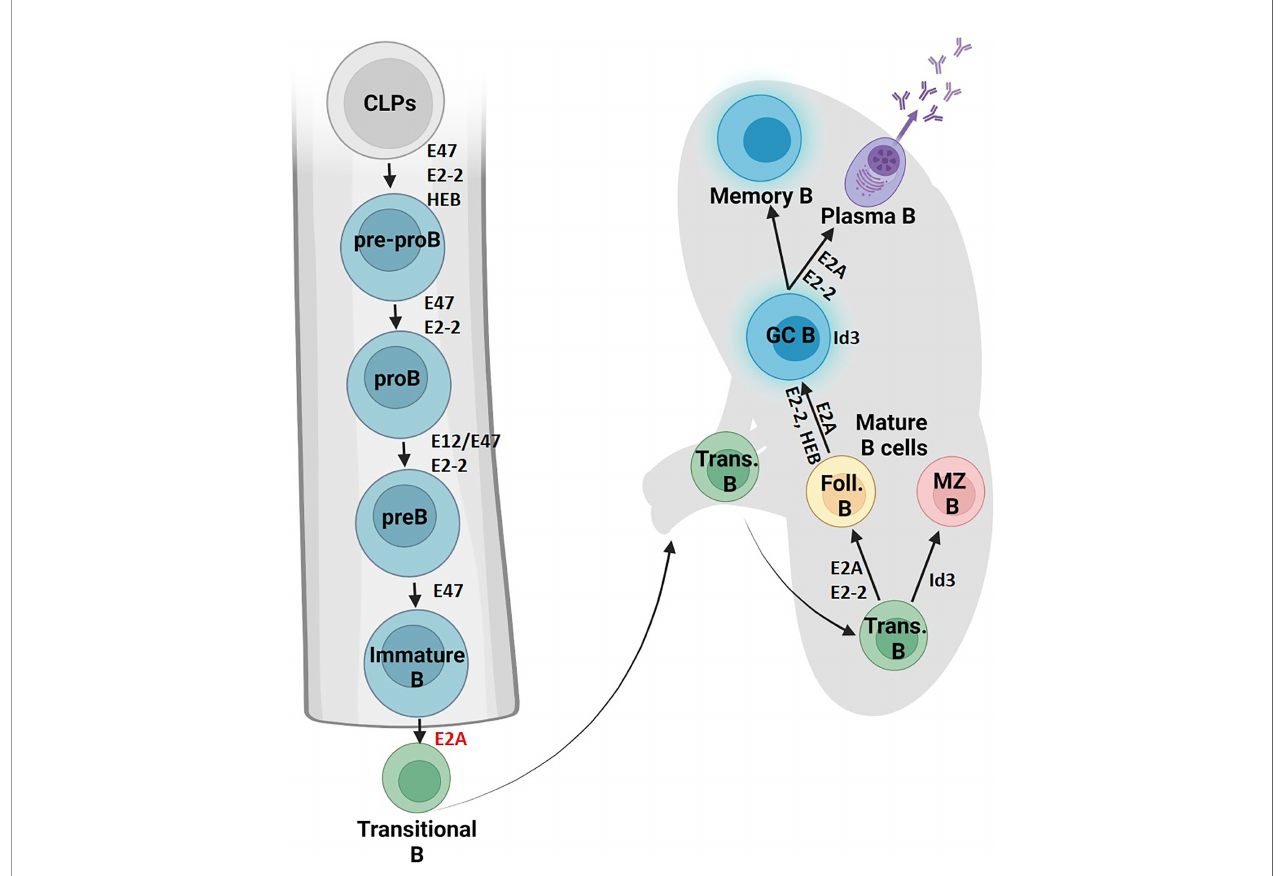
FIGURE 2 | B cell fate and differentiation is directed by E protein activity. The role of E proteins and their antagonists in B cell development is shown in the bone marrow and lymphoid organs. Protein factors supportive of differentiation or cell maintenance are indicated in black font next to the arrows or adjacent to the cell respectively. Protein factors with repressive functions are indicated in red font (Created with